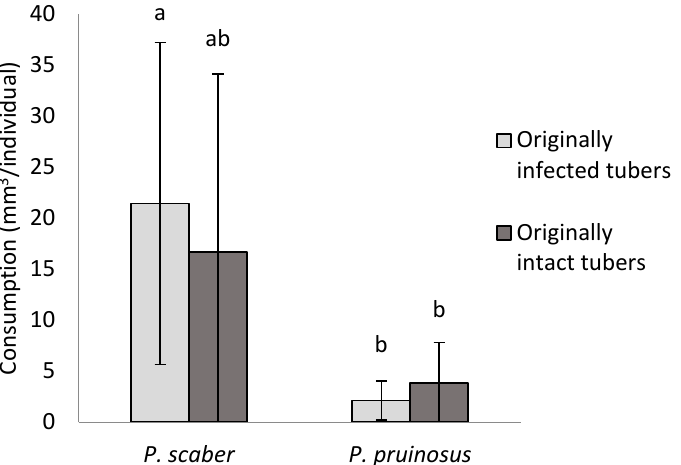
Figure 10. Difference between the consumption of infected and intact potato tubers by two isopod species ( Porcellio scaber , Porcellionides pruinosus ) in a feeding experiment where the animals were offered healthy and infected tubers (the same letters above the bars indicate the lack of a significant ( p ≤ 0.05) difference according to the Kruskal–Wallis test with Mann–Whitney pairwise comparisons, uncorrected significance; error bar: CI 95%).